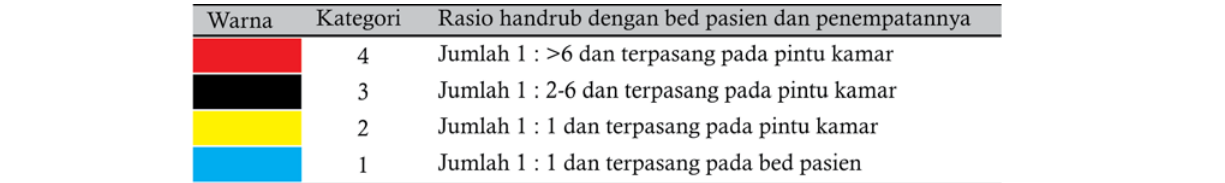
Tabel 5. Kategori titik handrub